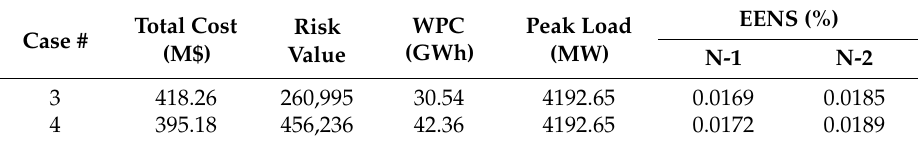
Figure 8. Corrective control cost (CC) distributions for cases 3 and 4 with increasing wind power. Table 5. Results comparison for cases 3 and 4 with 10% wind power.